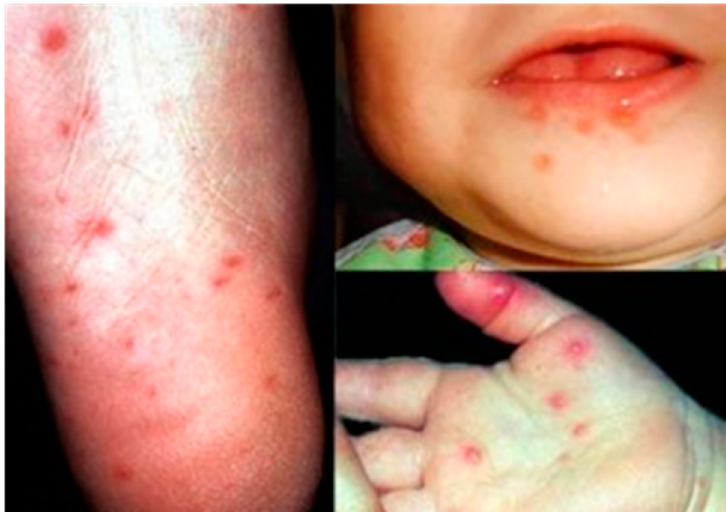
Figure 2. Vesicles on the foot, mouth and palm area of children infected with hand, foot and mouth disease (HFMD) [19]. Adapted from the Dermatologic Image Database, Department of Dermatology, University of Iowa College of Medicine, USA, 1996 (http://tray.dermatology.uiowa.edu/ImageBase). (Permission granted by University of Iowa)